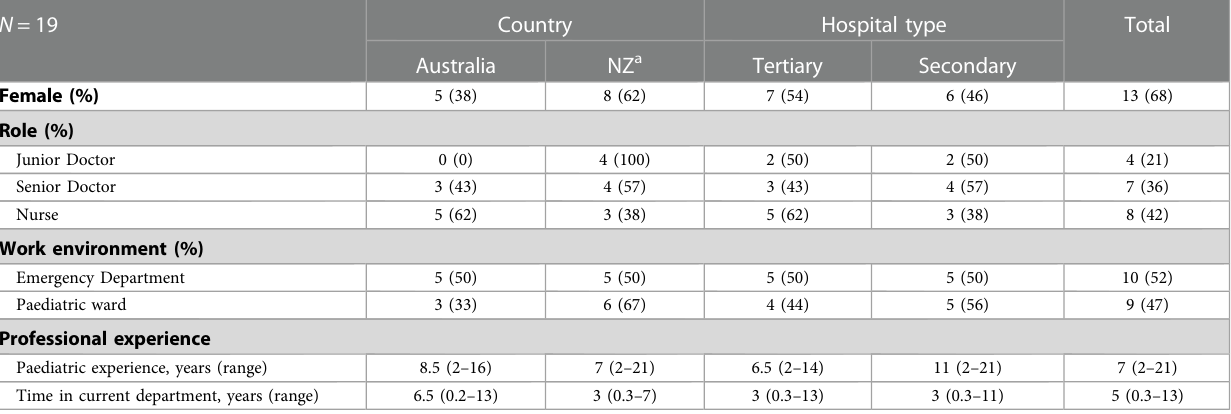
TABLE 1 Participants ’